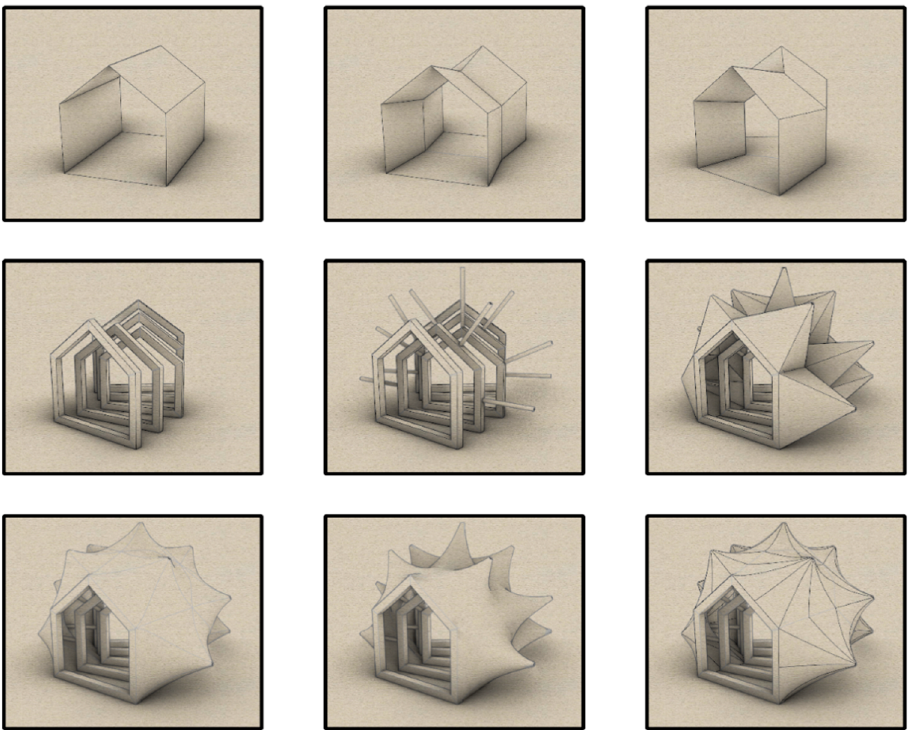
Figure 7. Development of the Obverse/Reverse Pavilion.